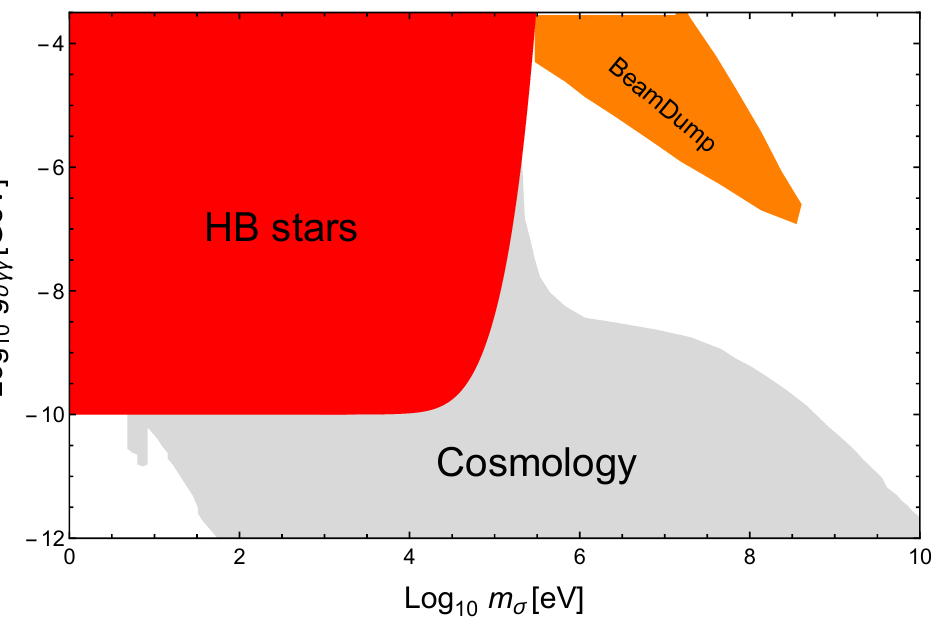
Figure 5. Limits of the coupling and the mass of the radion when g (cid:27)NN & 2 (cid:2) 10 (cid:0) 6 GeV (cid:0) 1 , modi(cid:12)ed from (cid:12)gure